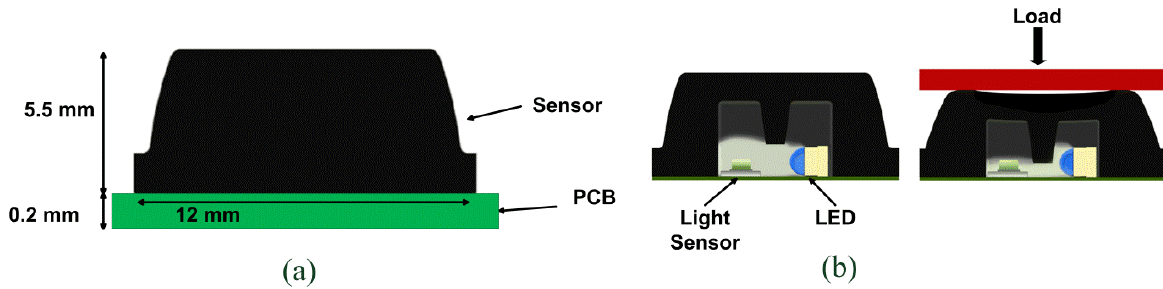
Figure 5. Overview of the second-generation PSP sensitive element: ( a ) dimension of the sensitive element, ( b ) transduction principle (adapted from [39], ©2011 IEEE. Reprinted with permission).